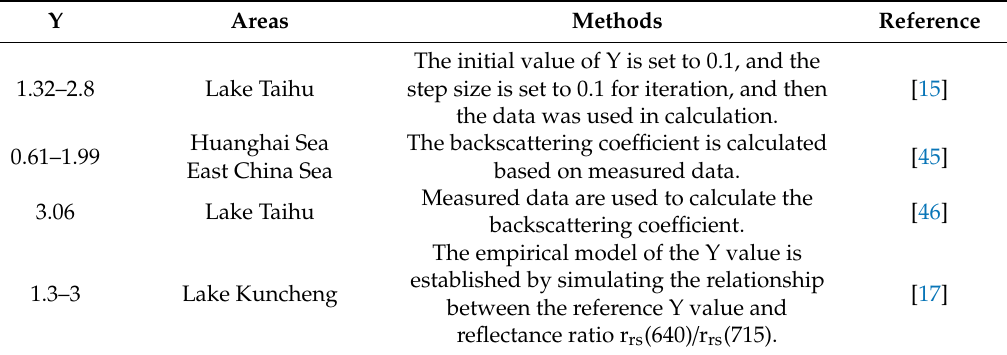
Table 2. Power value Y of different types of waters.